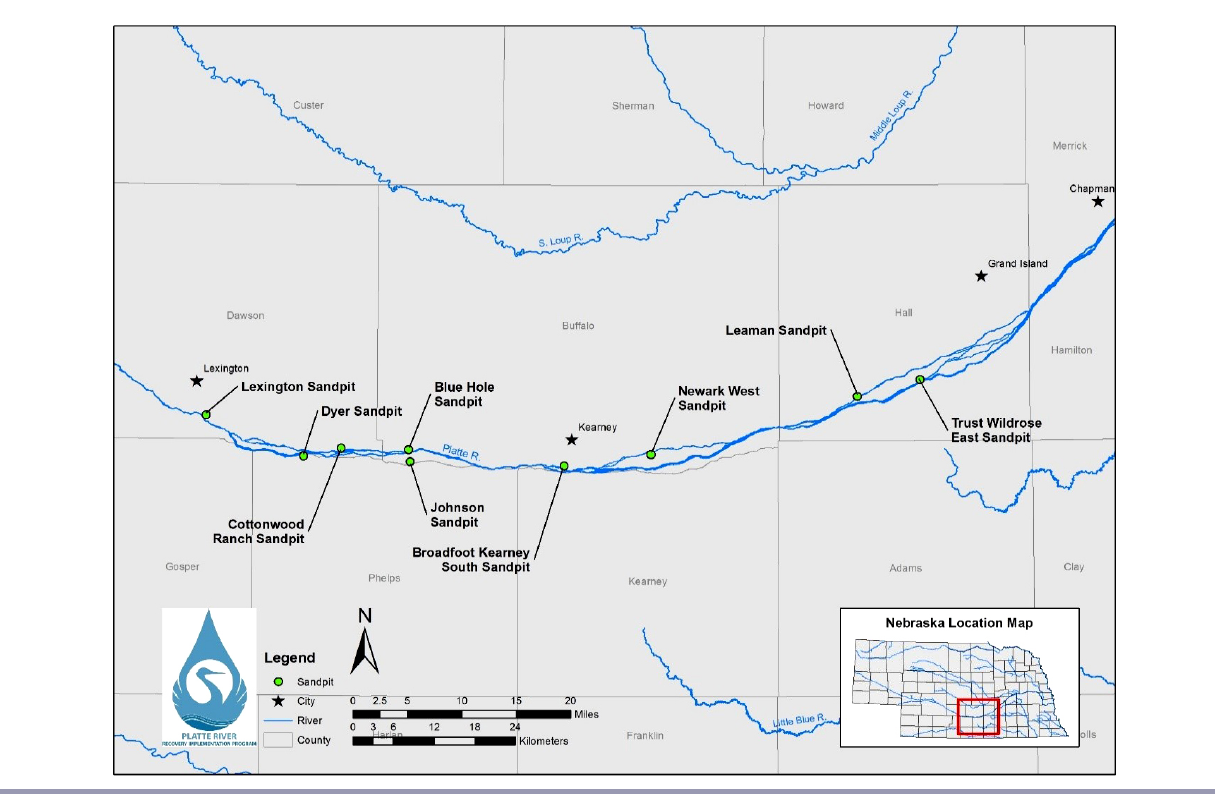
Fig. 1. Associated Habitat Reach (AHR) of the central Platte River extending from Lexington downstream to Chapman, Nebraska. Nine managed, off-channel nesting sites were included in the productivity analysis and were included as point